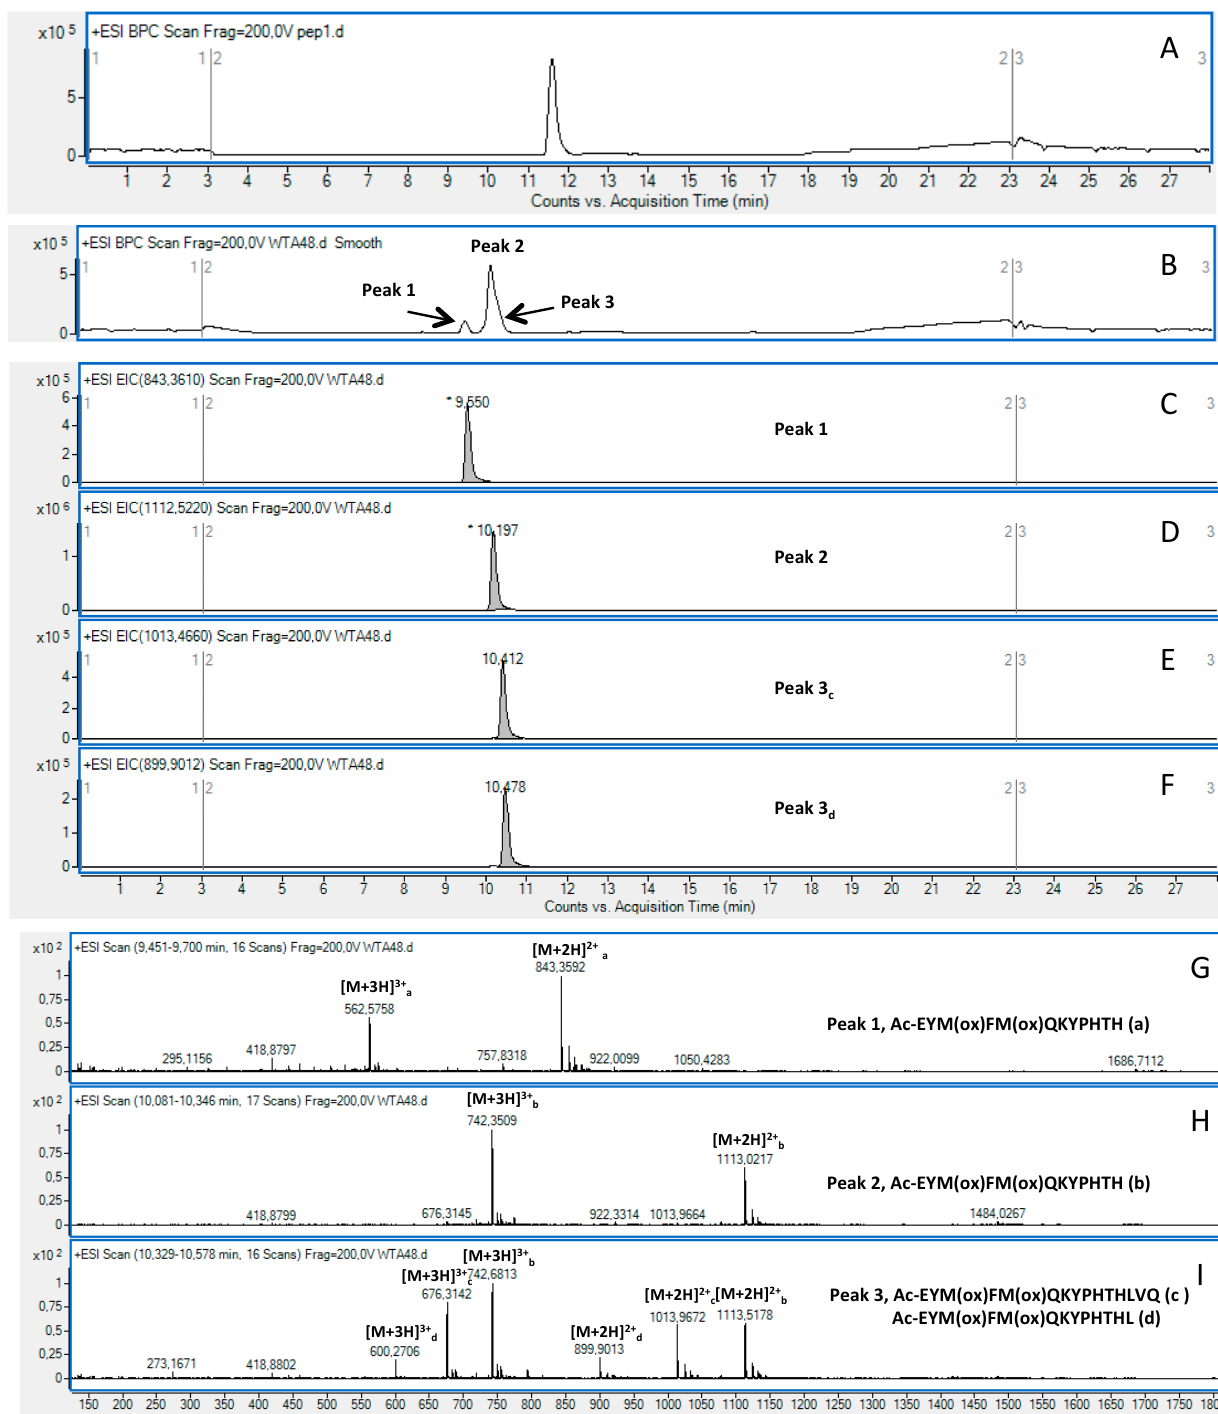
Figure 3. LC-MS analysis of the GDF11[48-64]ox before and after treatment with APEH for 48 h. Base Peak profiles of GDF11[48-64]ox ( A ) before and ( B ) after treatment with APEH where the 3 peaks generated are indicated by arrows. ( C – F ) EIC profiles of Peaks 1–3. ( F – I ) Mass spectra of Peak 1, Peak 2 and Peak 3. Under Peak 3, two main species were identified as the fragments Ac-EYM(ox)FM(ox)QKYPHTHLVQ (species c) and Ac-EYM(ox)FM(ox)QKYPHTHL (species d). The species identified are reported on the mass spectra.